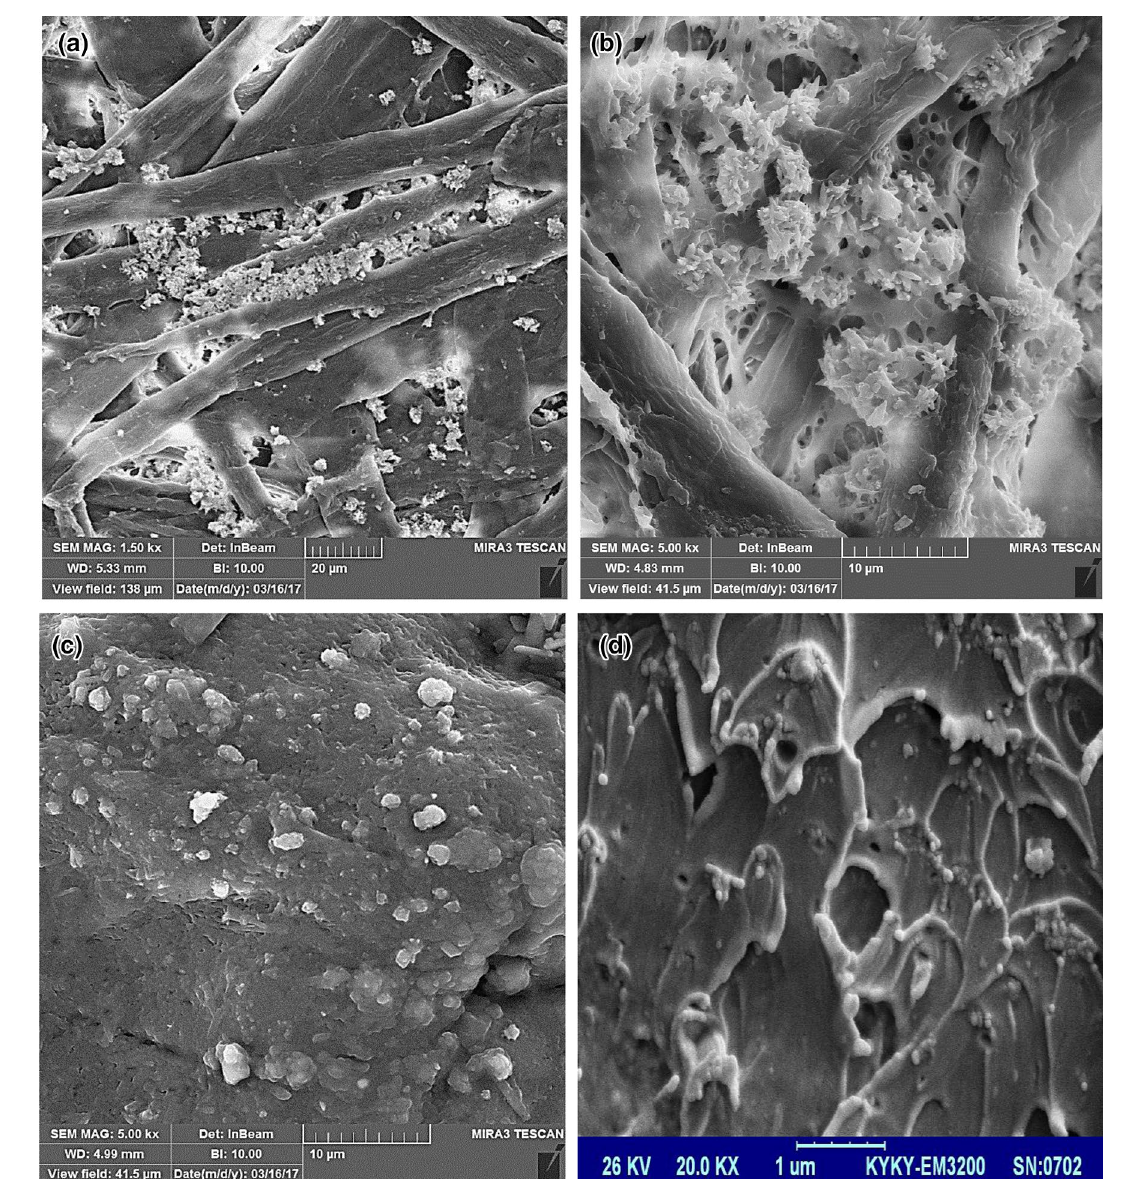
Fig. 7 SEM images of a PVDF gel electrolyte film, b PVA gel separator film, c PVA gel electrolyte film, d BaTiO